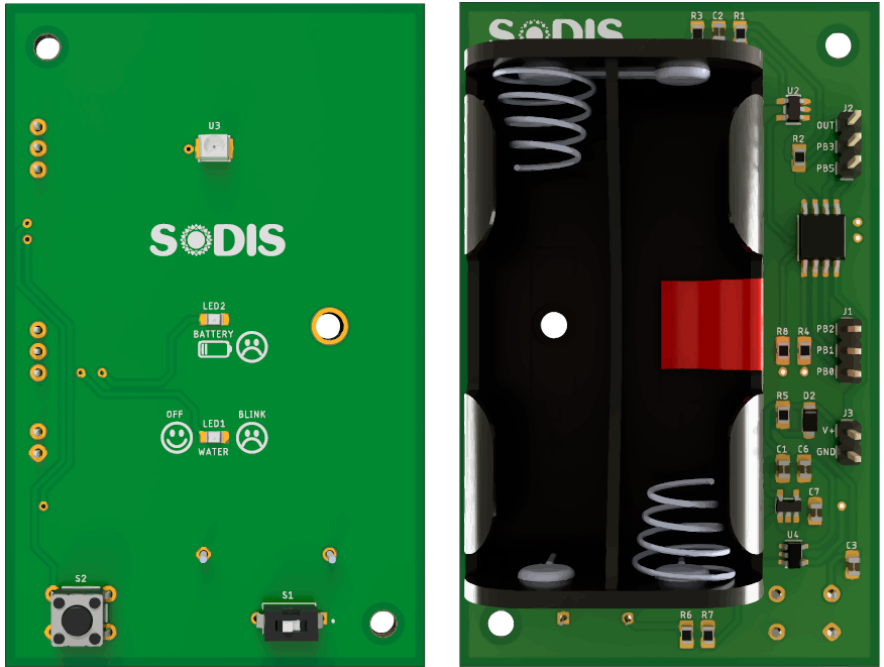
Figure 12. PCB device: top ( left ) and bottom ( right